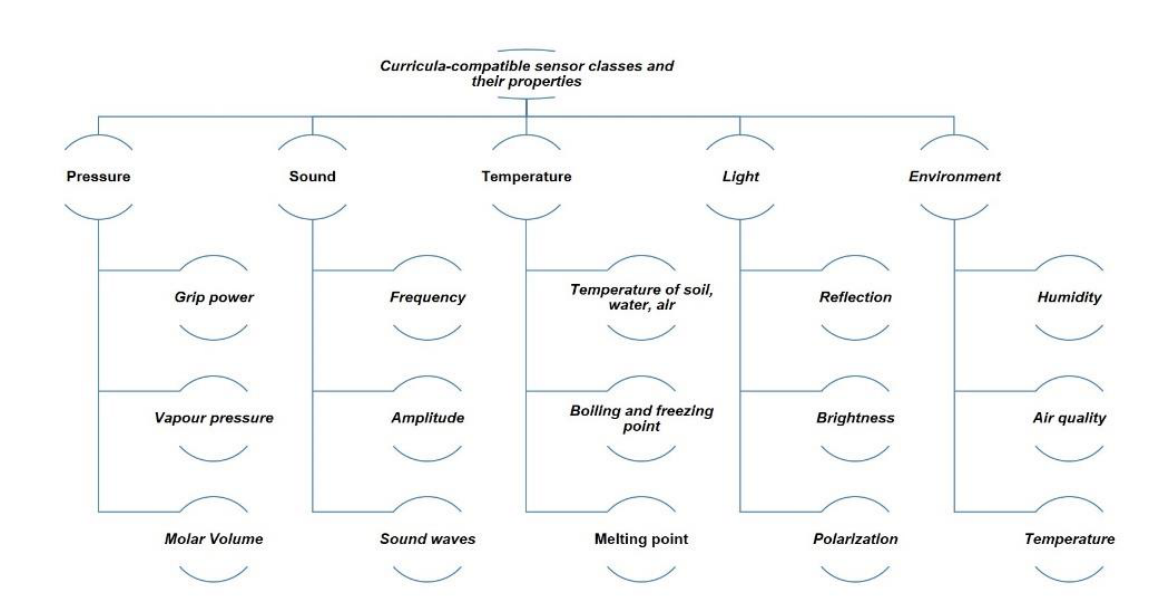
Figure 4. Curricula-compatible sensor classes and their properties ( N =